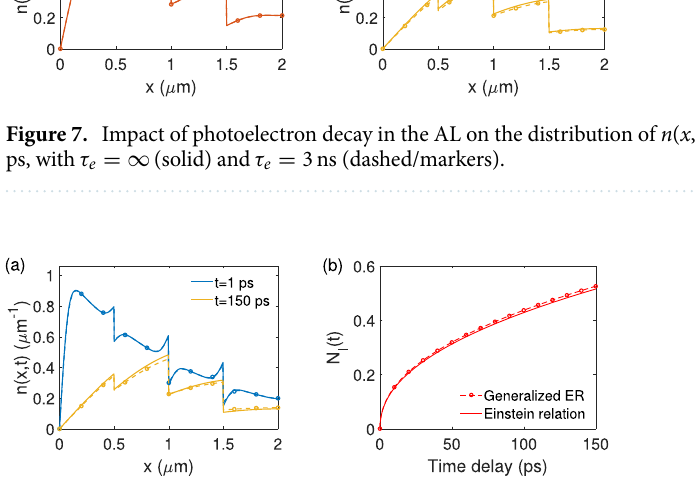
Figure 8. The effect caused by the generalized Einstein relation on ( a ) the electron distribution n ( x , t ) in the AL at different delay times and ( b ) the AL-to-BBR electron injection N I ( t ) . Results obtained using the Einstein relation are represented by solid lines. Results obtained using the generalized Einstein relation are represented by dashed lines with circular